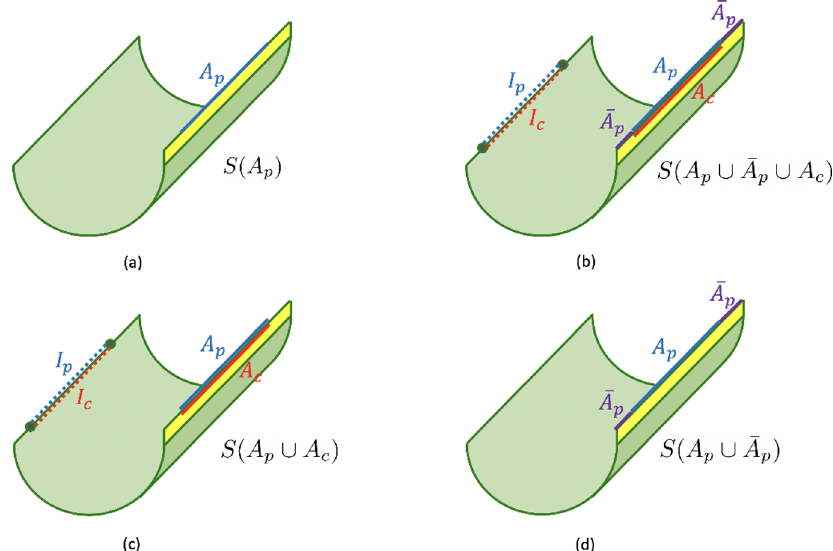
Figure 7 . We draw the regions involved in the computation of various entropies. The original regions in the definition of the entropy are drawn in solid, while the emergent regions (islands) are drawn in dotted lines. A crucial point is that we can view the euclidean evolution on the depicted half cylinder as preparing a state for the matter theory. This state lives on two lines, the one in the (yellow) non gravitational region and the one in (green) the middle of the